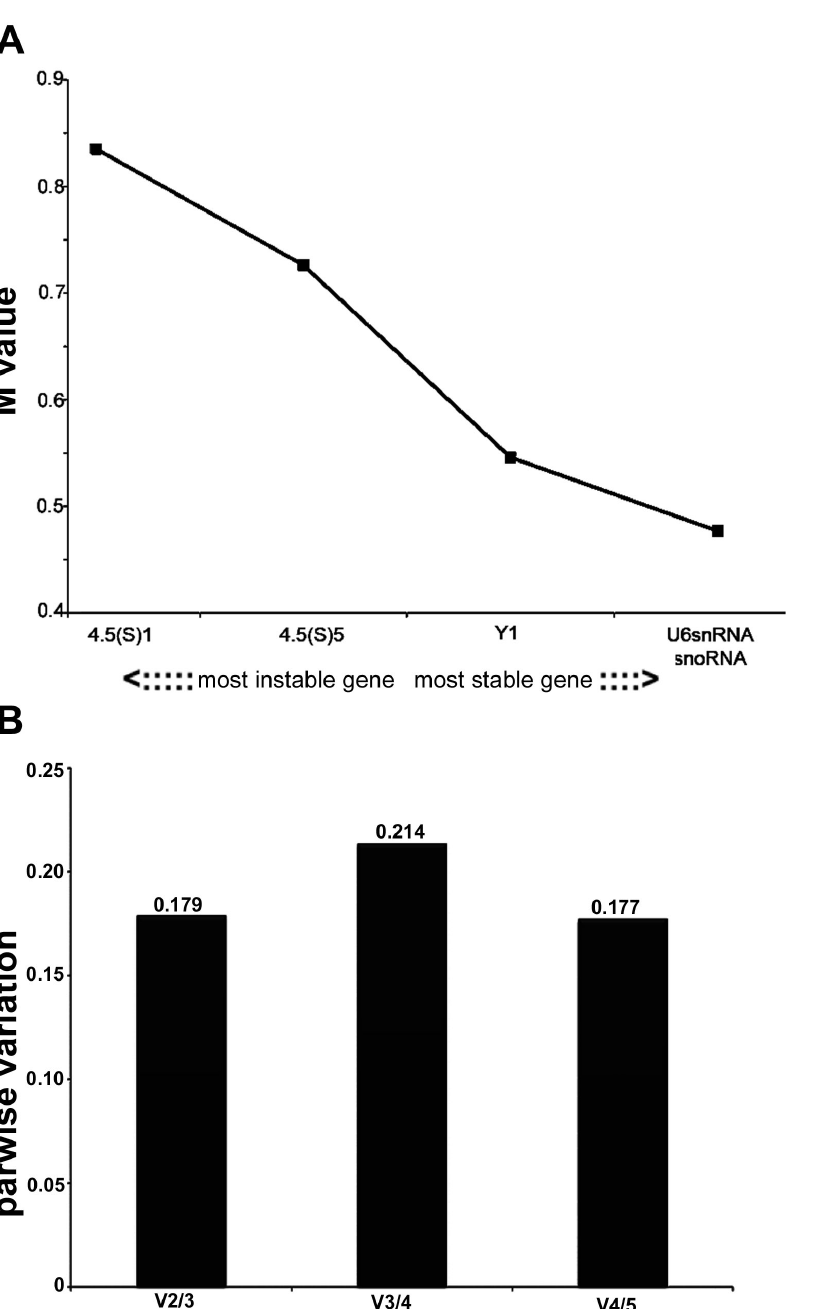
Figure 2. Selection of the most suitable reference genes for microRNA qRT-PCR analysis in the systemic PILO-model samples using geNorm analysis. A) Expression stability measurements (M) for the five reference genes analyzed. The x-axis from left to right indicates the ranking of the genes according to their expression stability; lower M values indicate higher expression stability. B) Determination of the optimal number of reference genes for normalization was conducted. The software calculates the normalization factor from at least two genes at which the variable V defines the pair-wise variation between two sequential normalization factors.